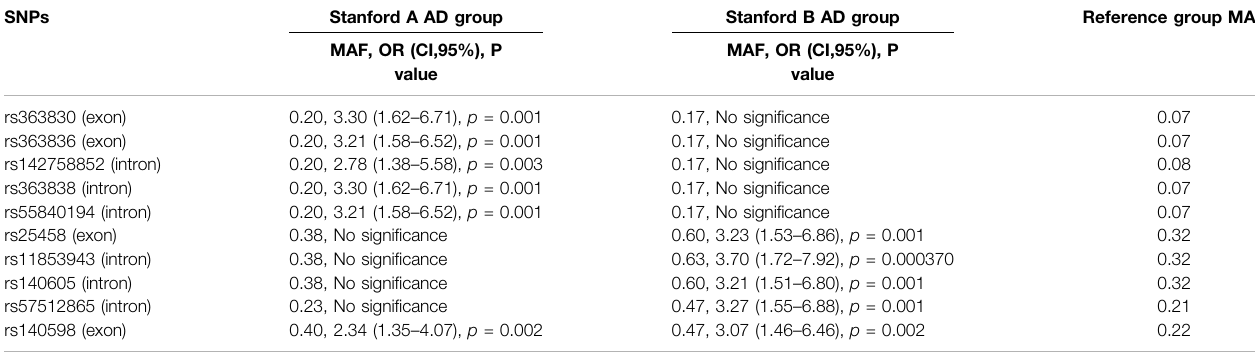
TABLE 4 | Detailed distribution of 10 signi fi cant SNPs in Stanford A AD and Stanford B AD. SNPs